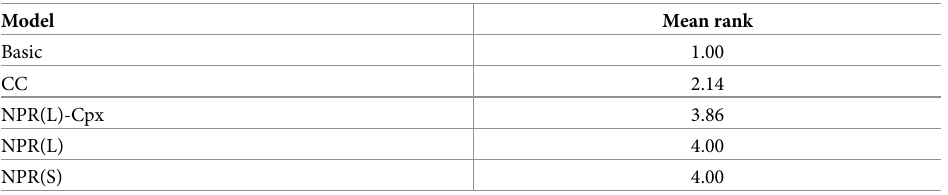
Table 7. Mean rank of the models based on the relationship scores, conducted on the 14 problem instances with- out N/A values. The higher the value, the better the